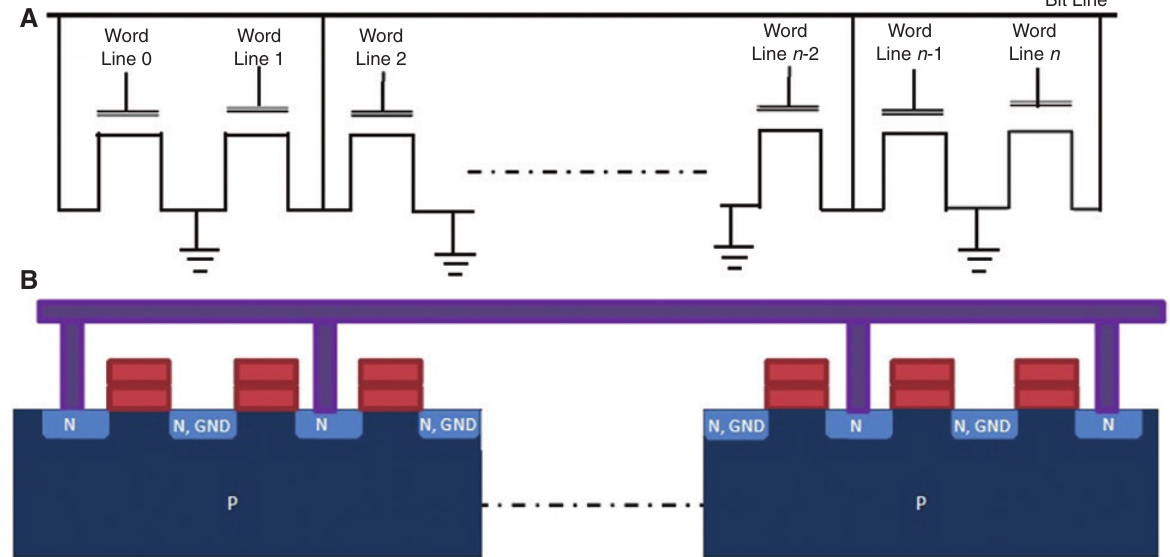
Figure 4: Schematic of SanDisk based NAND flash memory. (A) Cell structure showing the functionality of transistors in Word data from line 0 to line n , with the Ground Select and Bit Line transistors as the control gate transistors. (B) NMOS transistors representing the cell structure in (A).